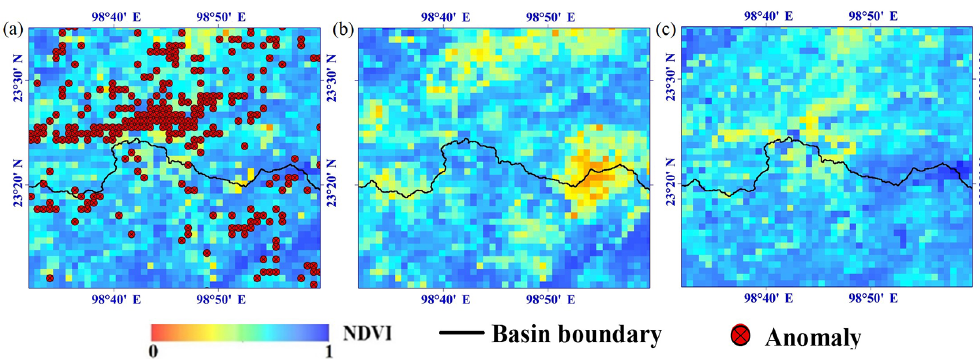
Figure A2. Comparison of three NDVI products over a ridge area on June 2006, (a) for MMD, (b) for MOD, and (c) for MYD.